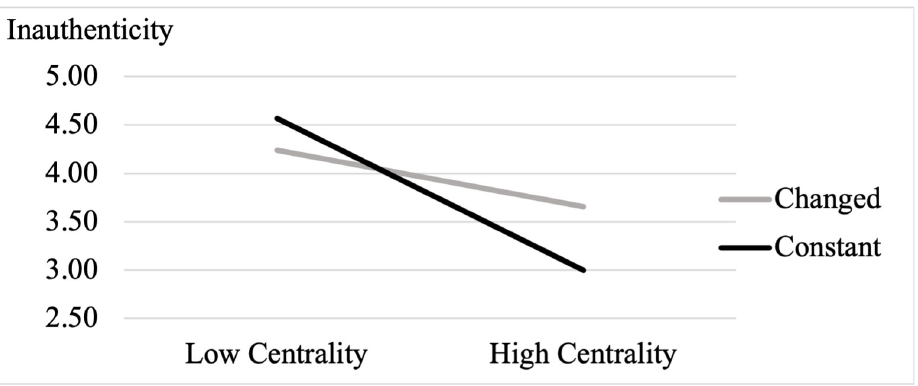
Fig 1. Interaction of role change and role centrality on state inauthenticity in Study